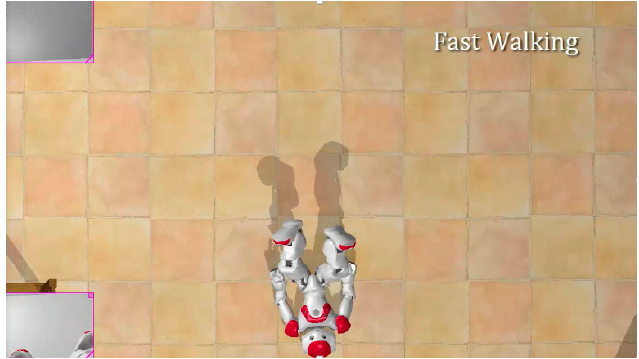
Figure 20. NAO in fast walking mode that had fallen down.